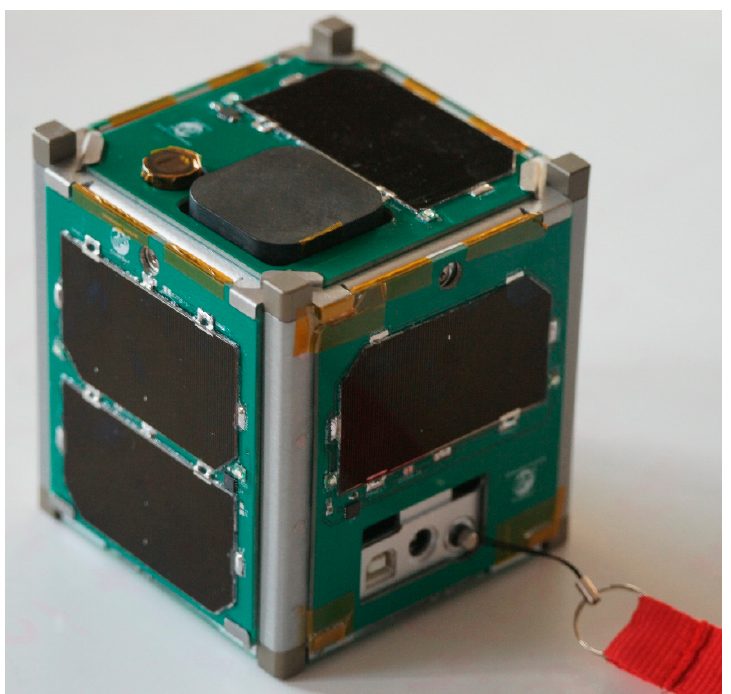
Figure 2. A typical 1U CubeSat [7].